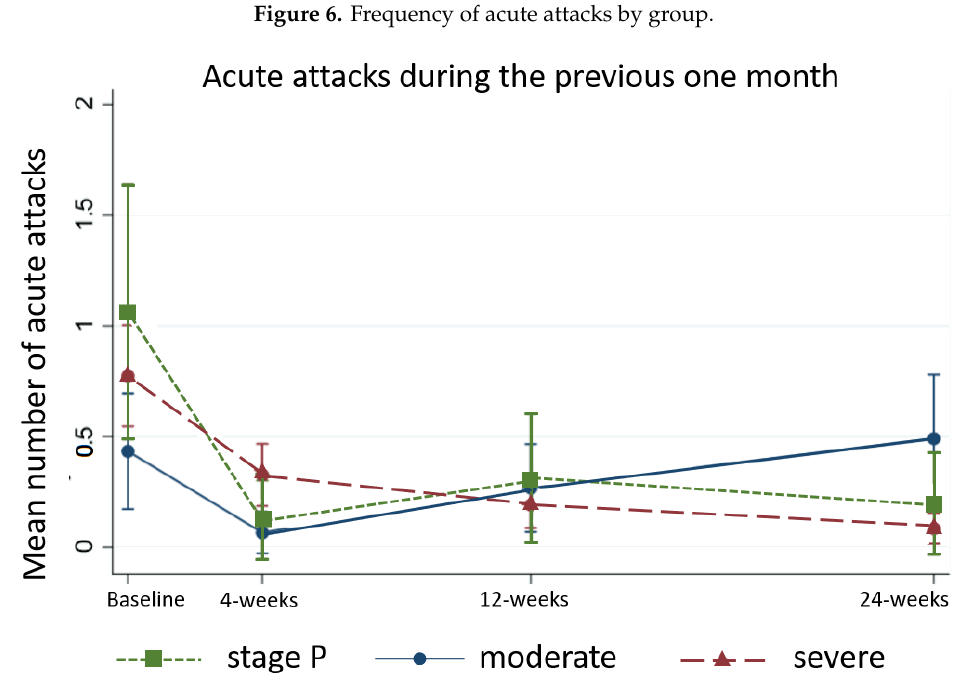
Figure 6. Frequency of acute attacks by group.